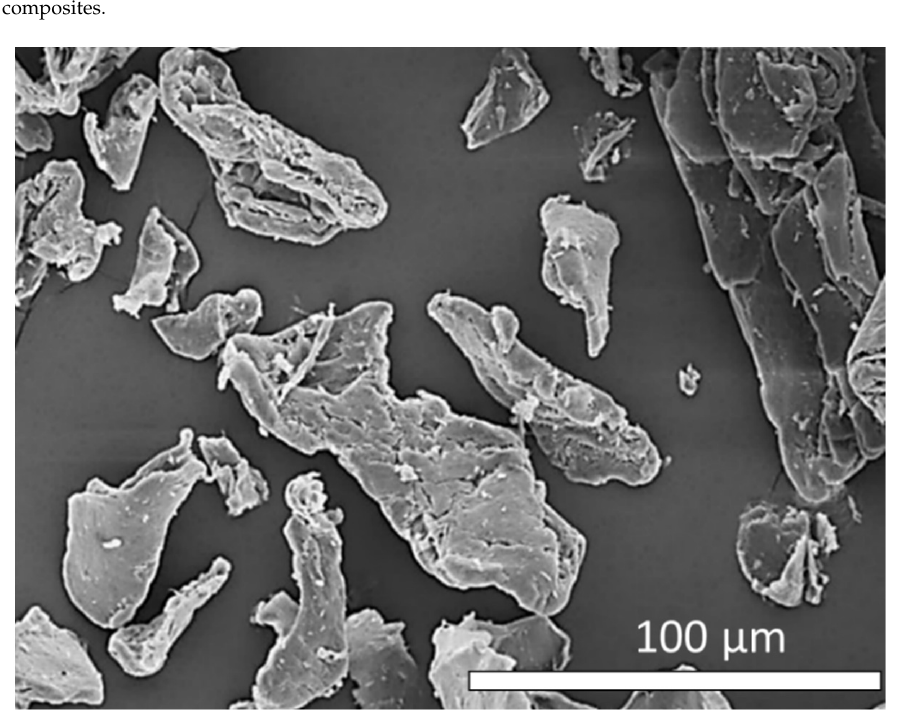
Figure 1. Micrograph image of chitosan (CS) used as a bio-filler in R-VNRL and RP-VNRL composites showing average particle size of 54 ± 5 µm. The image was taken at a magnification of ×500.